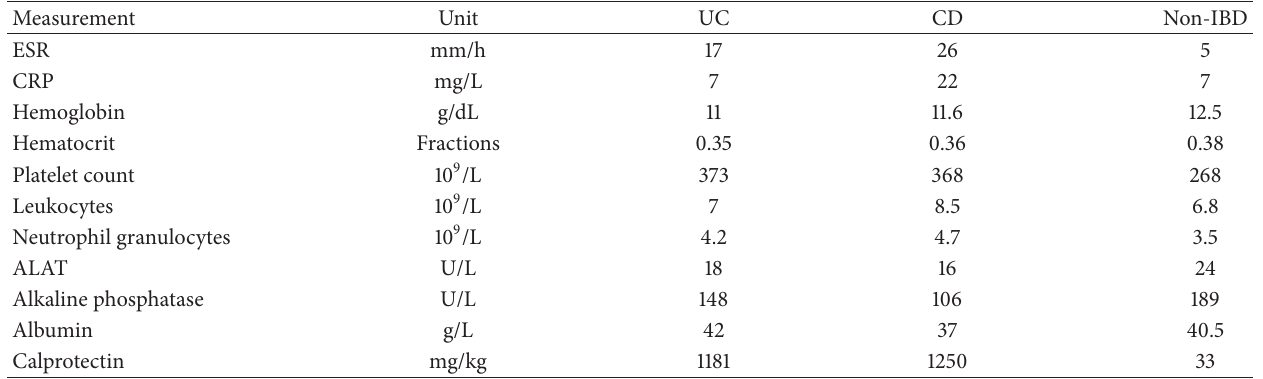
Table 3: Biochemical blood test levels and fecal calprotectin 1